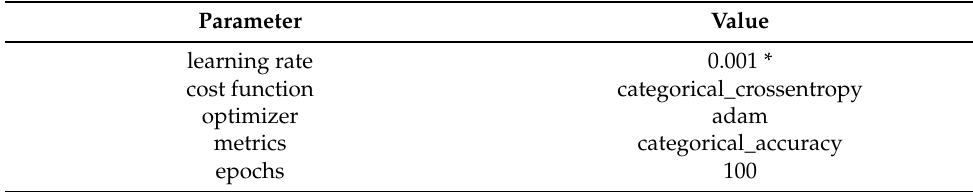
Table 2. Training parameters used in the training process.